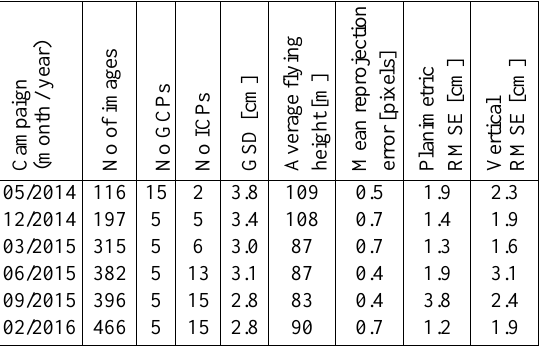
Table 1. Flight parameters and data processing details for six field campaigns at the Hollin Hill landslide.